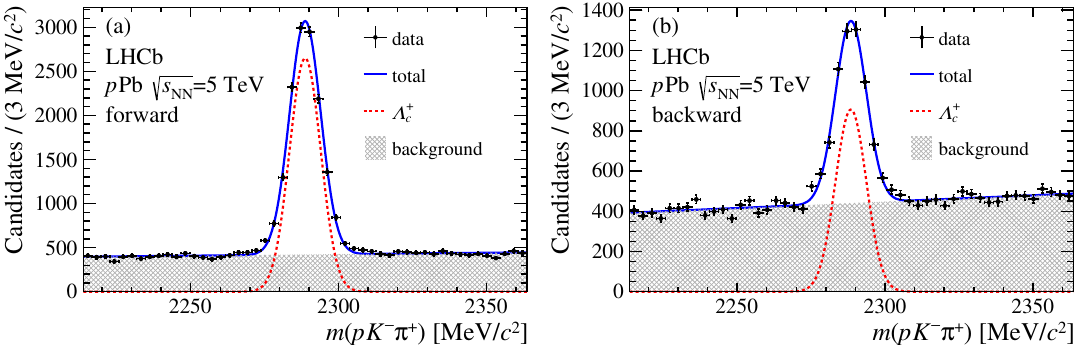
Figure 1 . Distributions of the invariant mass, m ( pK (cid:0) (cid:25) + ), in the range 2 < p T < 10 GeV